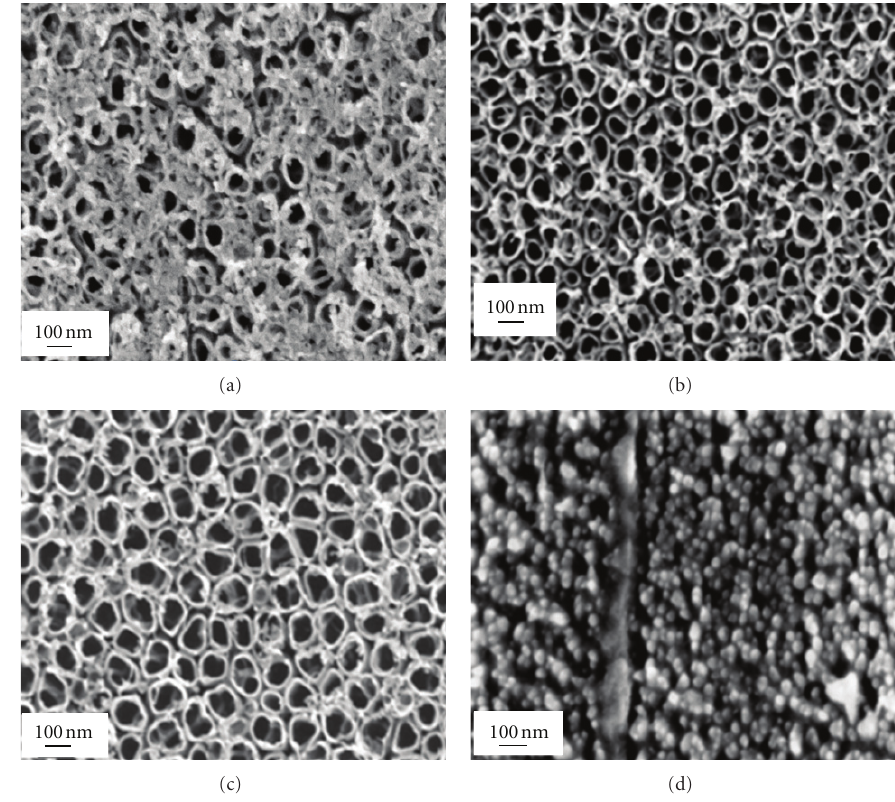
Figure 2: FESEM images of TNT synthesized at (a) 10 ◦ C, (b) 18 ◦ C, (c) 35 ◦ C, and (d) 40 ◦ C for 1 h.